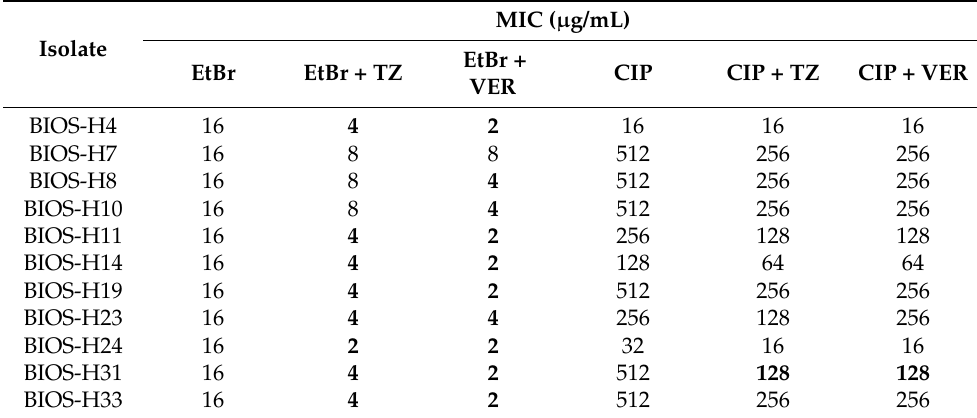
Table 2. The effect of the efflux inhibitors thioridazine and verapamil on ethidium bromide and ciprofloxacin MICs for selected S. aureus